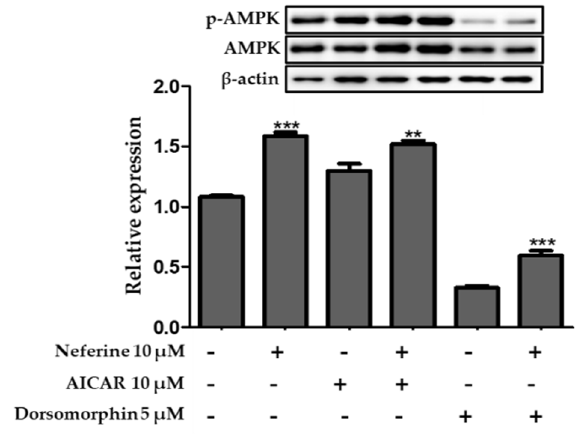
Figure 9. E ff ect of neferine in 3T3-L1 adipocytes treated with an inhibitor (dorsomorphin) and activator (5-aminoimidazole-4-carboxamide ribonucleotide (AICAR)) of AMPK. ** p < 0.01 and *** p < 0.001 vs. without Neferine. The ratio of p -AMPK / AMPK was analyzed using immunoblotting. All data are presented as mean ± SD, and experiments were performed at least thrice.